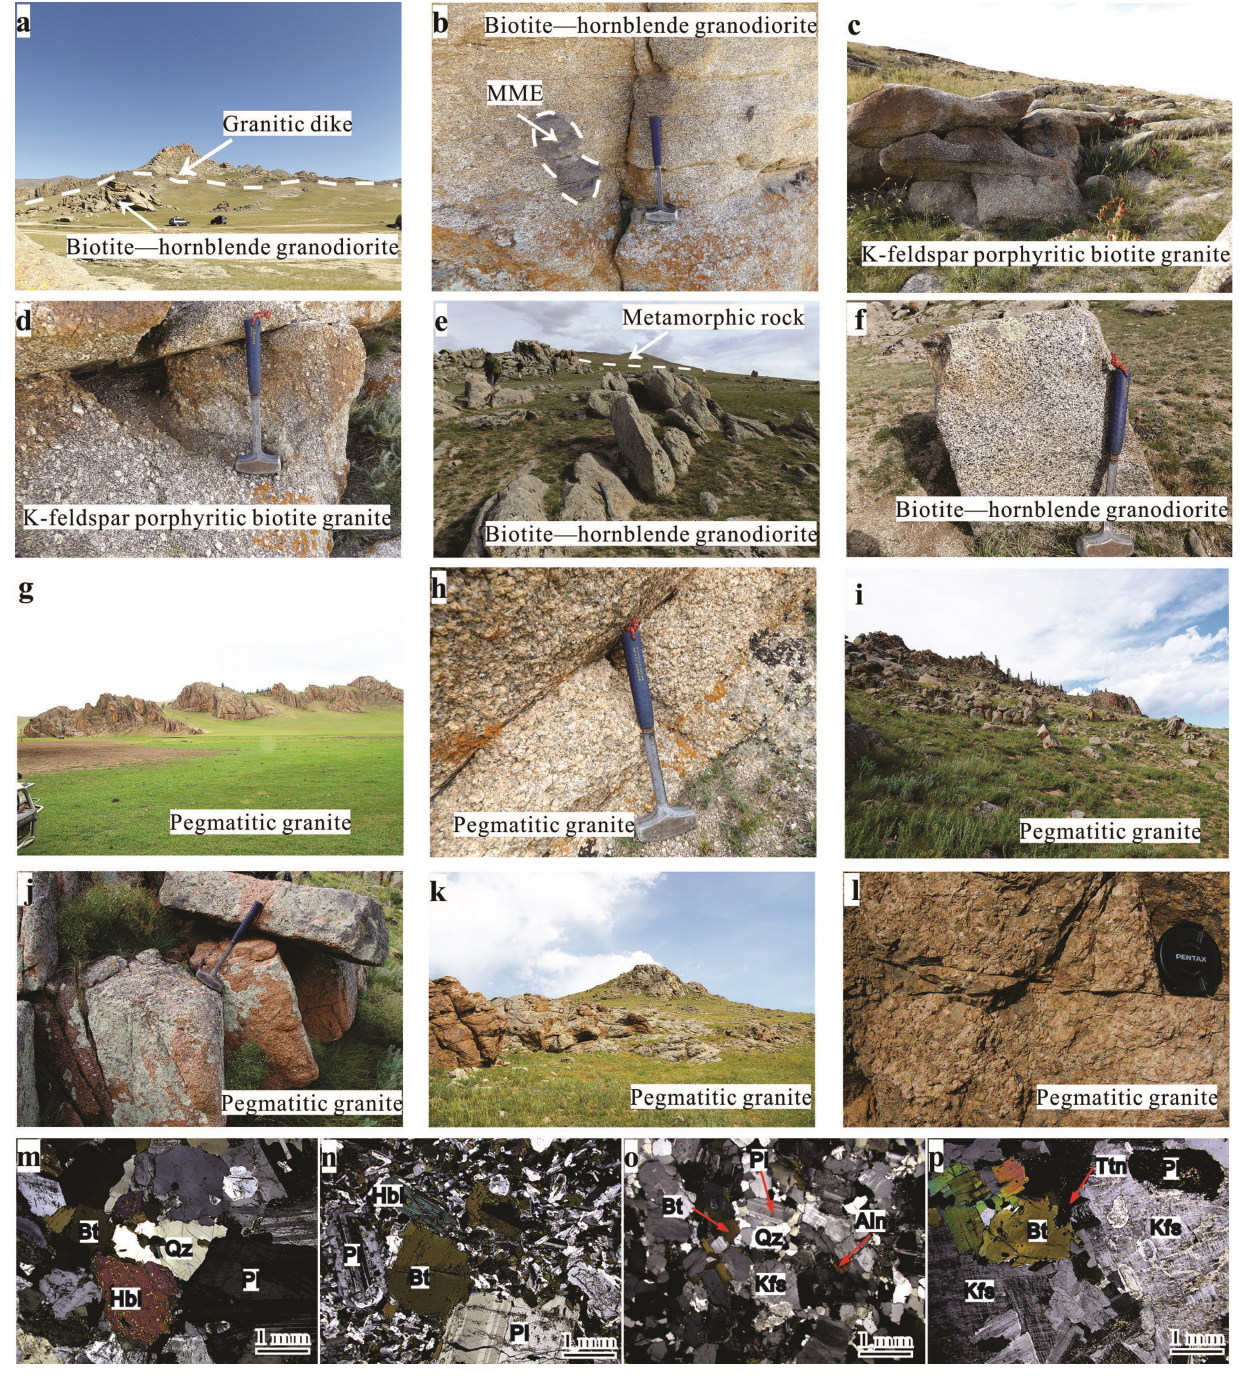
Fig. 3. Field setting of representative analyzed samples in the Khangai area. (a) Phaneritic biotite–hornblende granodiorite and granitic dike (samples 15082302A, B), (b) Phaneritic biotite–hornblende granodiorite containing MME (samples 15082302A, B), (c, d) K-feldspar porphyritic biotite granite (sample 15082306), (e, f) Phaneritic biotite–hornblende granodiorite and metamorphic rock (samples 15082603A, B), (g, h) Coarse-grained allotriomorphic pegmatitic granite (sample 15082504), (i, j) Red-colored coarse-grained allotriomorphic pegmatitic granite (sample 15082606A), (k-l) Coarse-grained allotriomorphic pegmatitic granite (sample 15082707), (m) Biotite– hornblende granodiorite (sample 15082401A), (n) MME (sample 15082502C) within the biotite–hornblende granodiorite, (o) Biotite granite (sample 15082402A1), (p) Pegmatitic granite (sample